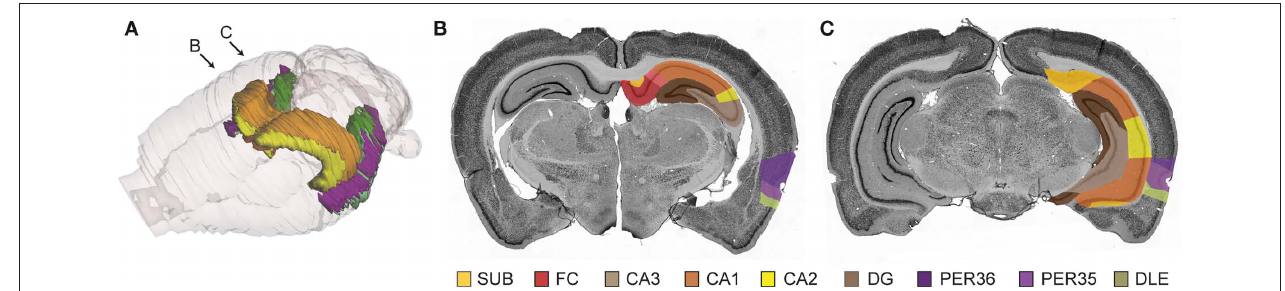
Figure 1 | The hippocampal region in 3-D and examples of atlas images from the rat Hippocampal Atlas. (A) 3-D reconstruction showing color-coded surface representations of hippocampal structures (based on the atlas presented in Hjornevik et al., 2007). Arrows indicate locations of images shown in B and C. (B,C) Atlas images of NeuN stained sections with graphical overlay showing color-coded segmentation of the hippocampal region, as presented in the Rat Hippocampal